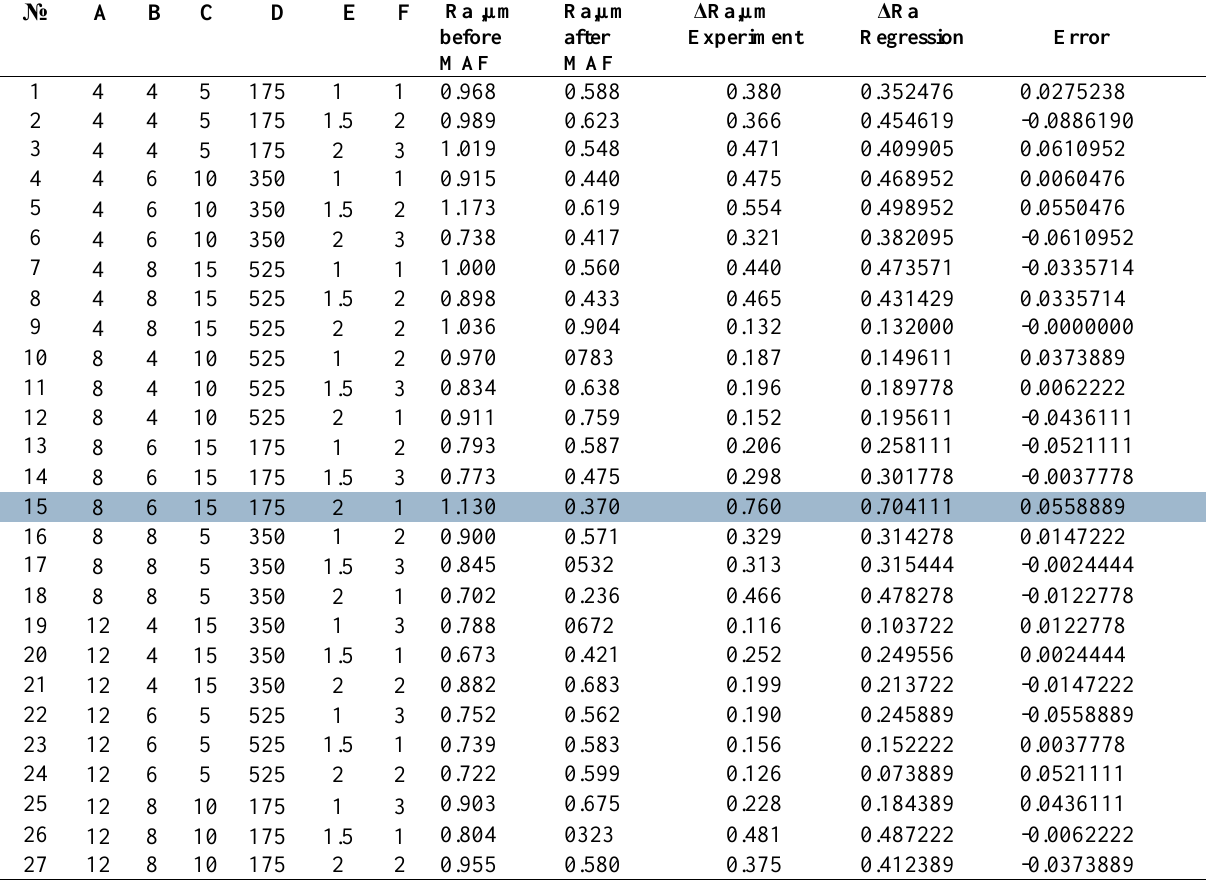
Table 5, Input parameters distribution according to Taguchi orthogonal array(OA ) with result of experiments and regression for ferromagnetic material stainless steel 316